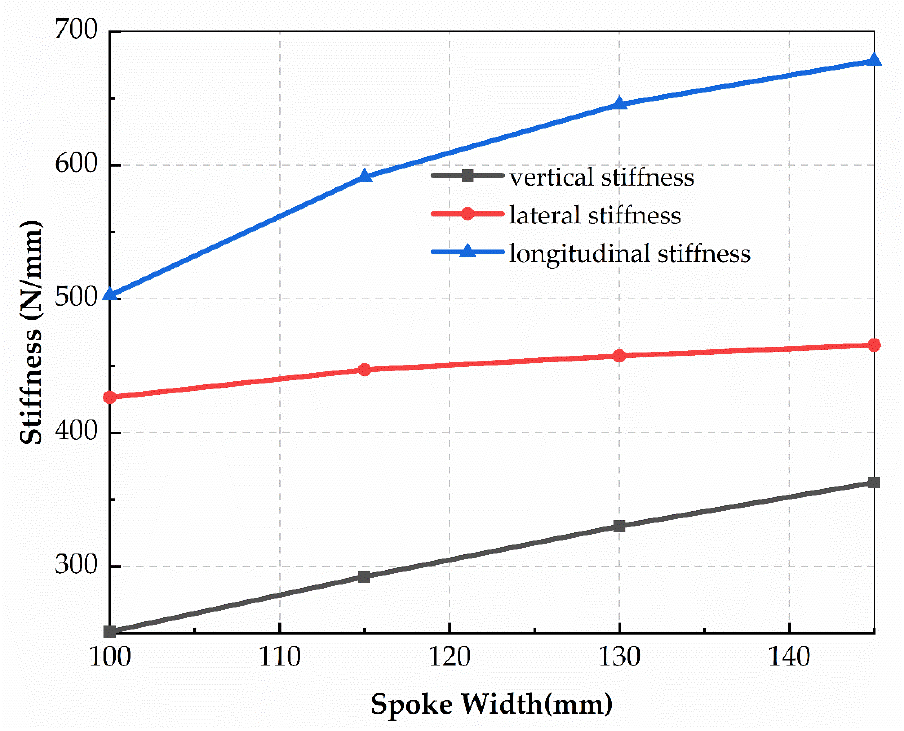
Figure 11. Effects of the spoke width on the three-dimensional stiffnesses of the FS-NPT.